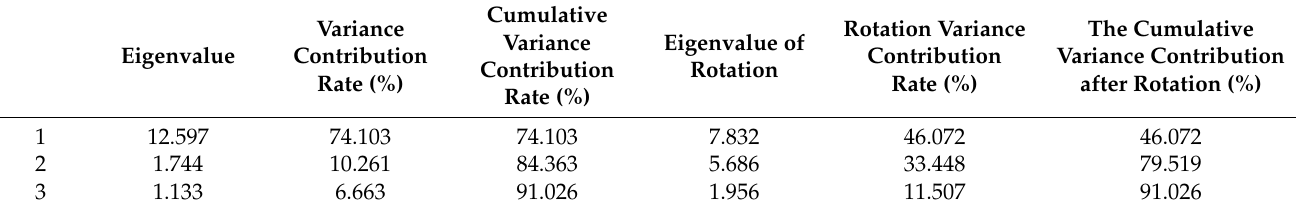
Table 17. Principal component eigenvalue and contribution